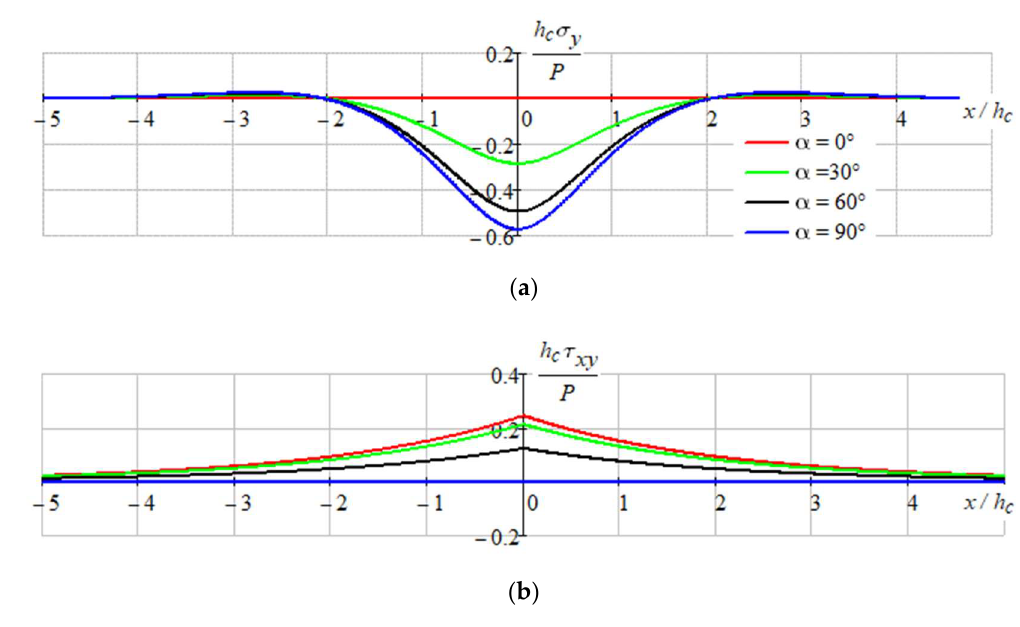
  ; and ( b ) — xy in the filter layers. Figure 10. Distribution of stresses: ( a )— σ y ; and ( b )— τ xy in the filter layers.